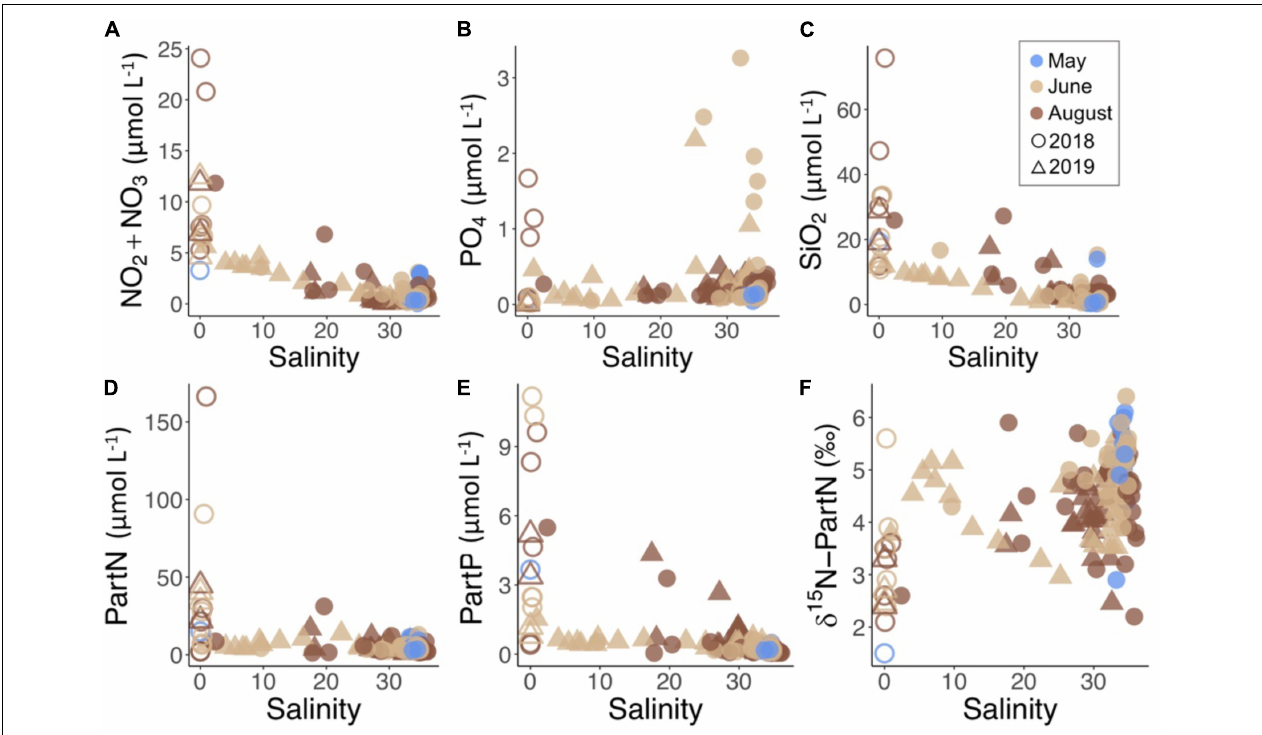
FIGURE 5 | Concentrations of dissolved nutrients (A) NO 2 + NO 3 , (B) PO 4 , (C) SiO 2 and particulate nutrients (D) particulate nitrogen (PartN), (E) particulate phosphorus (PartP), and (F) δ 15 N-PartN vs. salinity for each water sample by year (symbol) and month (color). River samples are further distinguished by open symbols.